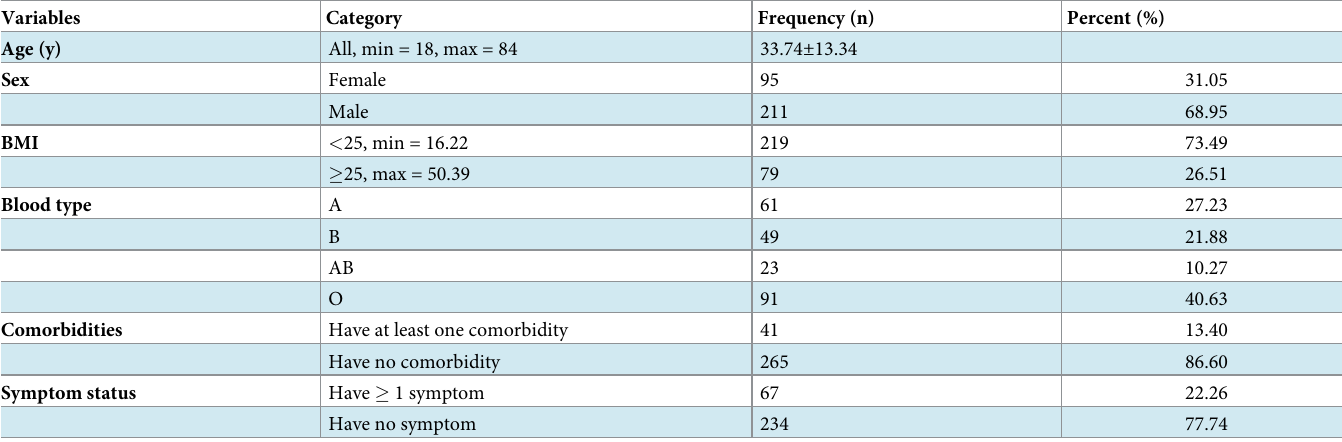
Table 1. Background characteristics of study participants admitted at the Eka Kotebe General Hospital, COVID-19 Isolation and Treatment Center, 2020. Variables